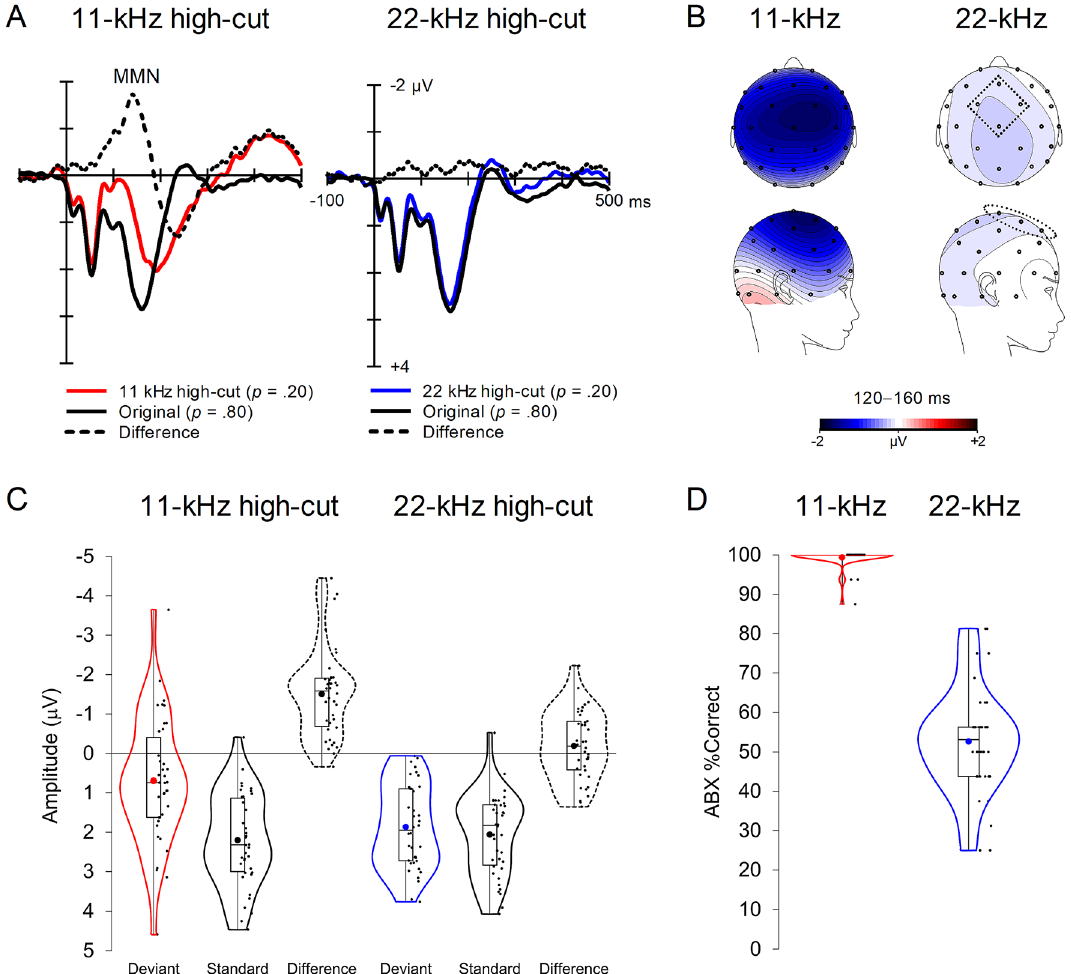
Figure 1. Results of mismatch negativity (MMN) response and behavioural discrimination. ( A ) Grand mean waveforms of the event-related brain potential to white noise bursts ( N = 38). ( B ) Scalp topographic maps of the MMN response. ( C ) Amplitude of the MMN latency range (120–160 ms). ( D ) Accuracy of the ABX auditory discrimination test. In sum, a white noise burst produced an MMN response and could be discriminated behaviourally only when it lacked audible sound